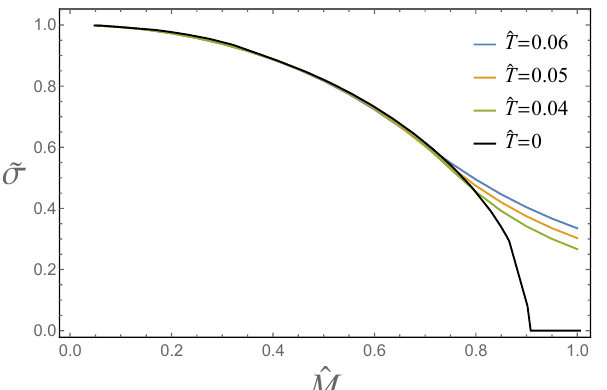
Figure 10. For ˆ M 2 = ˆ M 1 = ˆ M , the order parameter ˜ σ (we use ˜ σ as the axis label for simplification since ˜ σ A = ˜ σ Z = ˜ σ ) as a function of ˆ M at T/b = 0 . 06 , 0 . 05 , 0 . 04 and zero temperature with c/b = 1 . q 1 = q 2 = 1 and λ 1 = λ 2 = 1 / 10